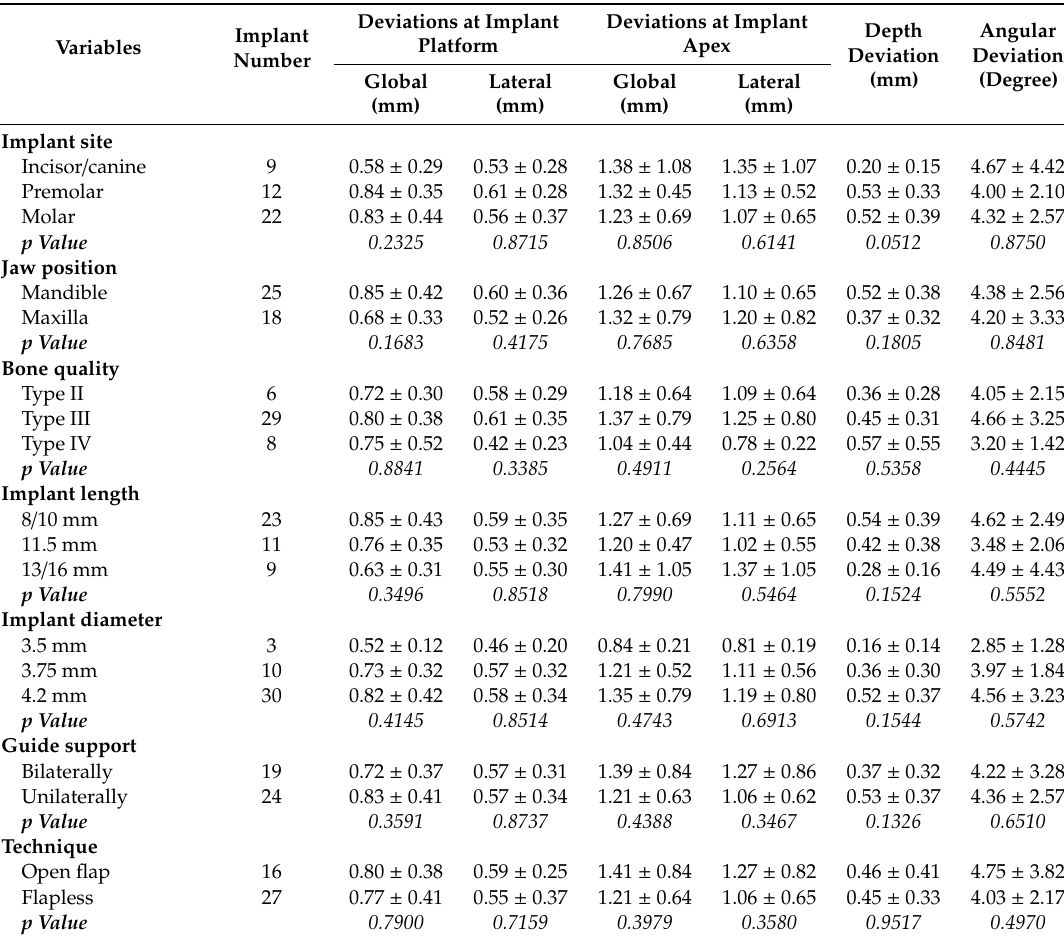
Table 2. Comparison of deviations for the examined